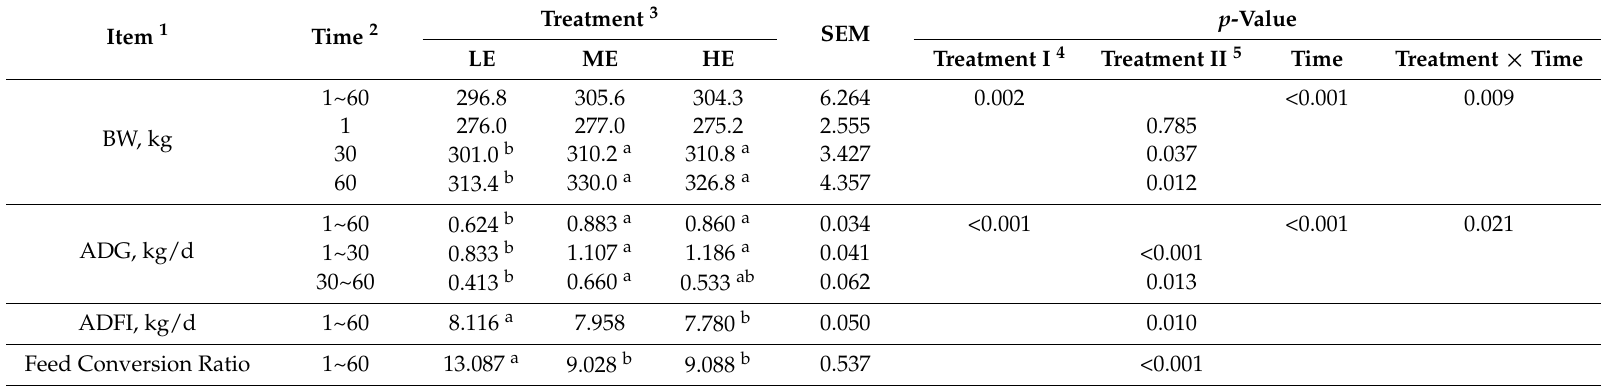
Table 3. Growth performance of yaks fed with different dietary energy